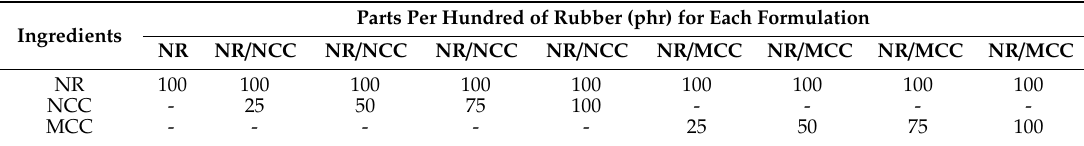
Table 1. Formulations of rubber